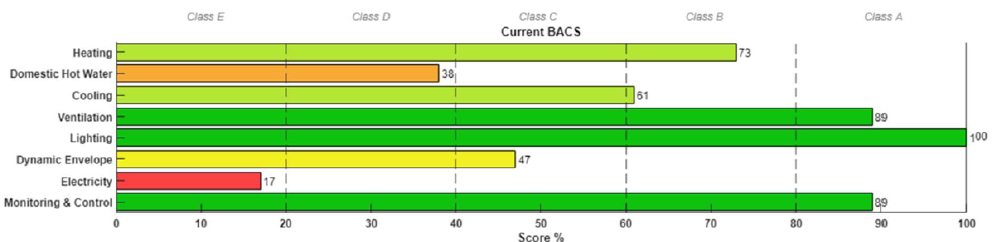
Figure 7. BACS auditing results for case study B along with domains assessment classes, the greener the bar color the higher the rating.